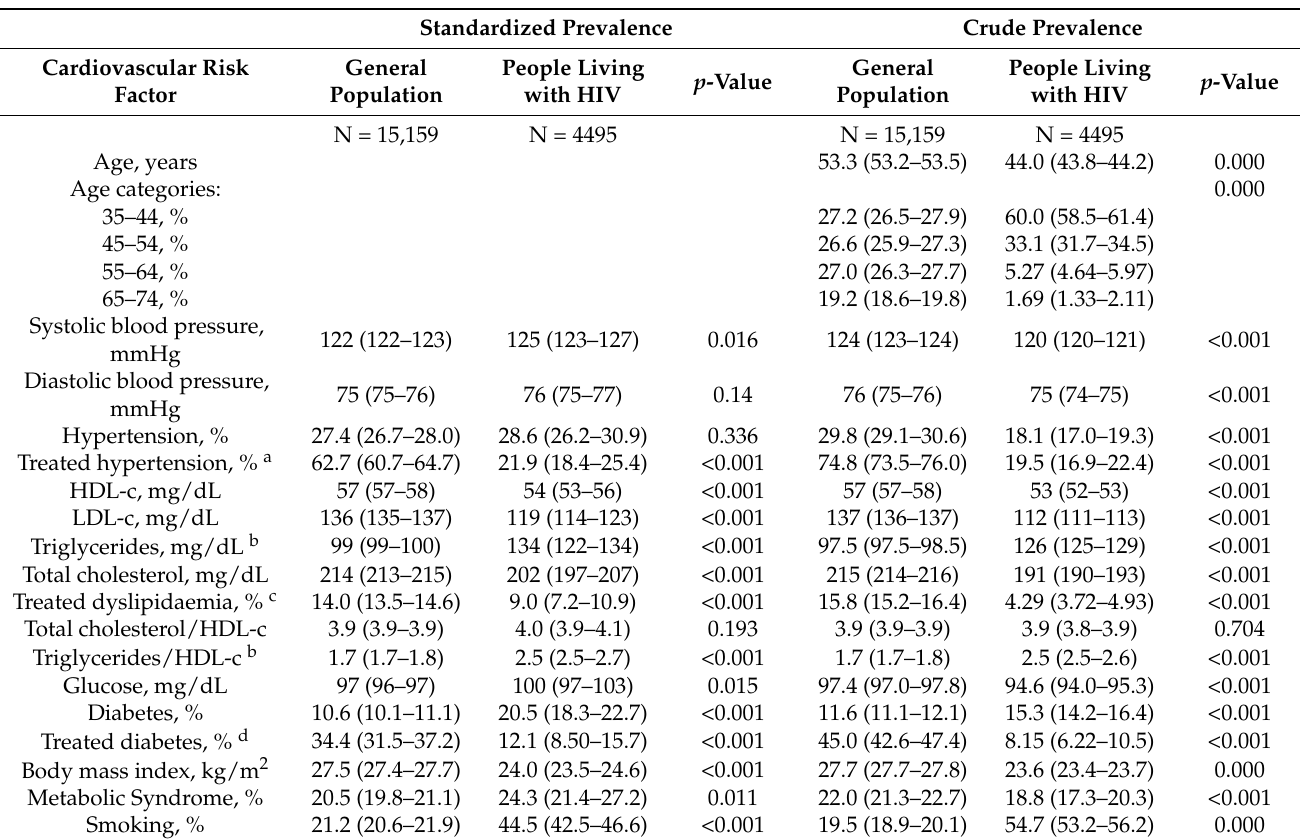
Table 1. Standardized and crude prevalence of cardiovascular risk factors in women from the general population and women living with